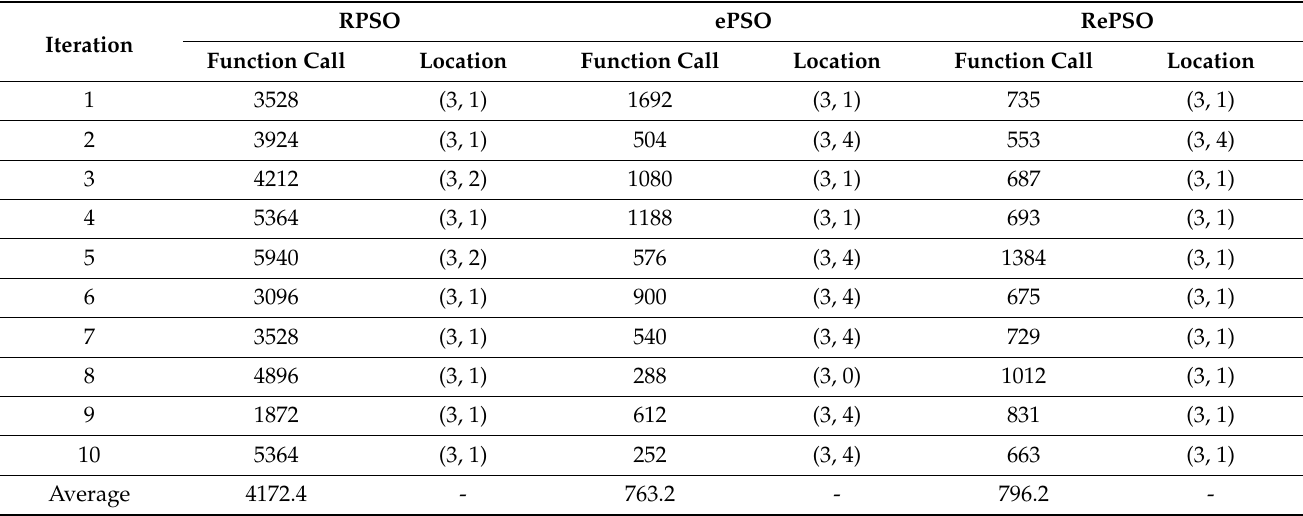
Table 2. Test results of the test function.